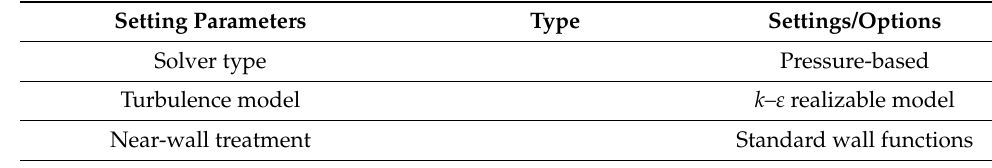
Table 3. Settings of the computational fluid dynamics (CFD) Model.